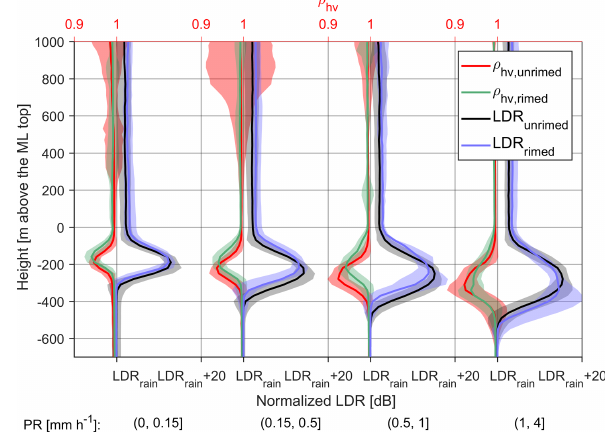
Figure 7. Same as Fig. 5 but for LDR observed by